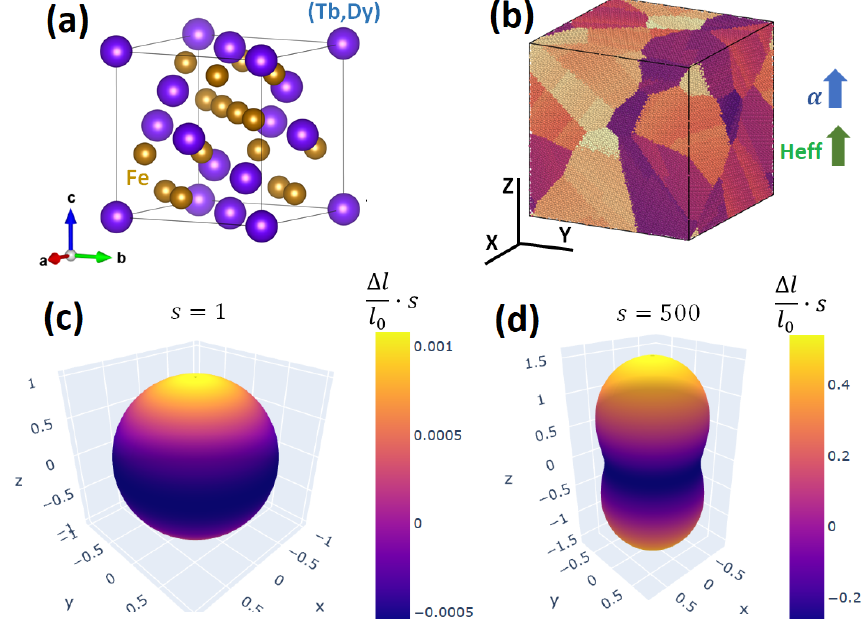
Figure 8. Mapping the Joule effect to a sphere for polycrystalline Terfenol-D at room-temperature under an effective magnetic field parallel to the z-axis. ( a ) Unit cell of Terfenol-D. ( b ) Atomistic model of polycrystalline Terfenol-D. 3D visualization of the simulated length l sim with scale factor ( c ) s = 1 and ( d ) s = 500. The color of the surface corresponds to the relative length change multiplied by the scale